Question: Author a descriptive caption for the visualization shown.
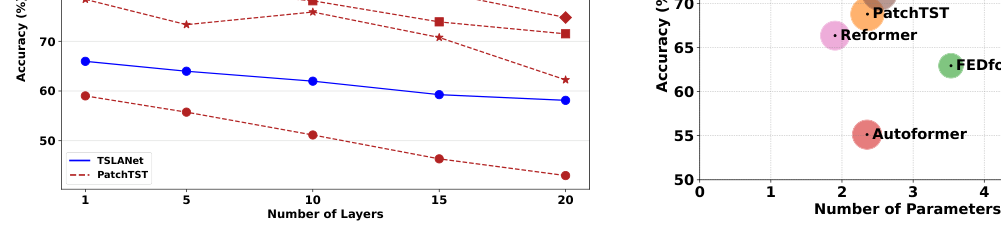
Answer: A comparison between TSLANet vs. PatchTST in terms of accuracy with varying the number of layers in both for different data percentages from the uWaveGesture- LibraryAll dataset.